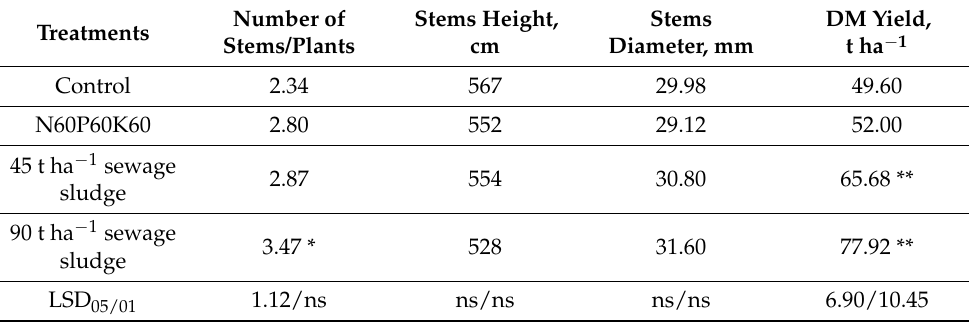
Table 1. The structural parameters of the common osier’s yield after 4 years of cultivation. Number of Stems Height, Stems DM Yield, Treatments Stems/Plants cm Diameter, mm t ha − 1 Control